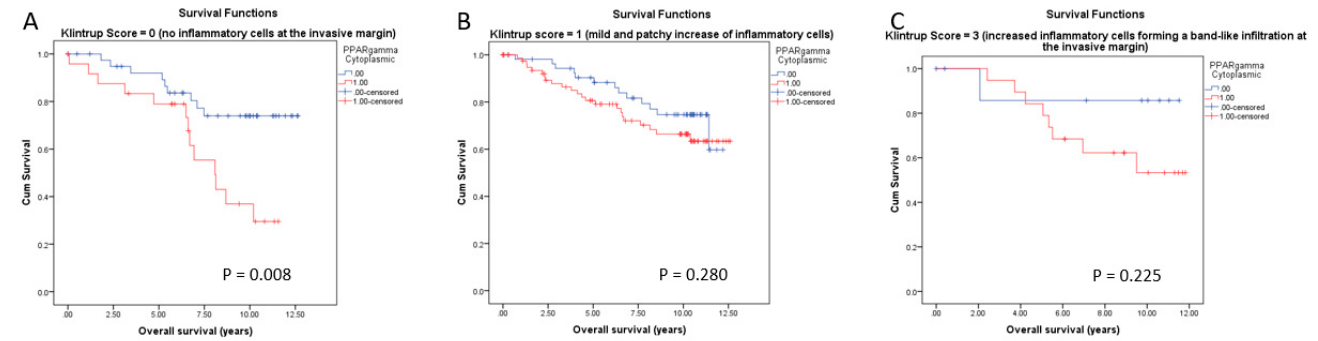
Figure 11. Kaplan–Meier survival analyses for cytoplasmic PPAR γ in relation to the level of peritu- moral inflammation with no inflammatory cells at the invasive margin (Klintrup Score 0 ( A )), mild and pathy increase of inflammatory cells (Klintrup Score 1( B )) and increased inflammatory cells (Klintrup Score 2 ( C )) on overall survival (OS).